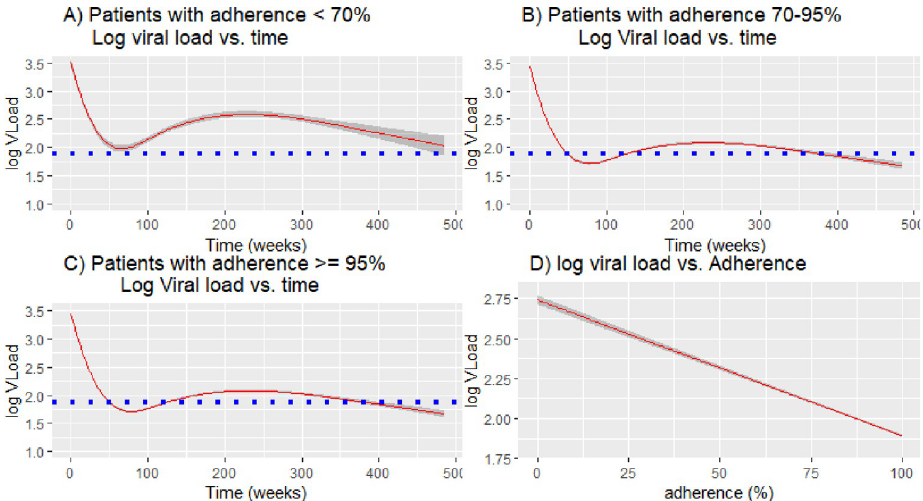
Fig 3. (A) Fitted model of log10 viral load vs. time in weeks among patients with adherence < 70% throughout the study;(B) Fitted model of log10 viral load vs. time in weeks among patients with adherence between 70% & 95% throughout the study; (C) Fitted model of log10 viral load vs. time in weeks patients with adherence > = 95% throughout the study; (D) Fitted model of log10 viral load vs. adherence (%). Blue dotted lines represent the lowest point of viral load